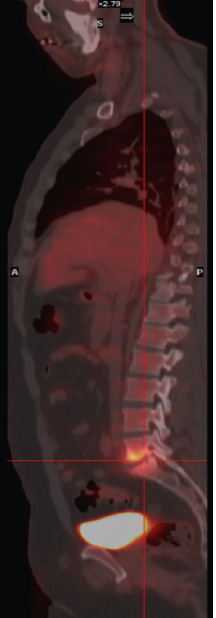
Figure 2: FDG-PET/CT scan of patient 2 showing an intense metabolic uptake between the lower plate of L5 and the upper plate of